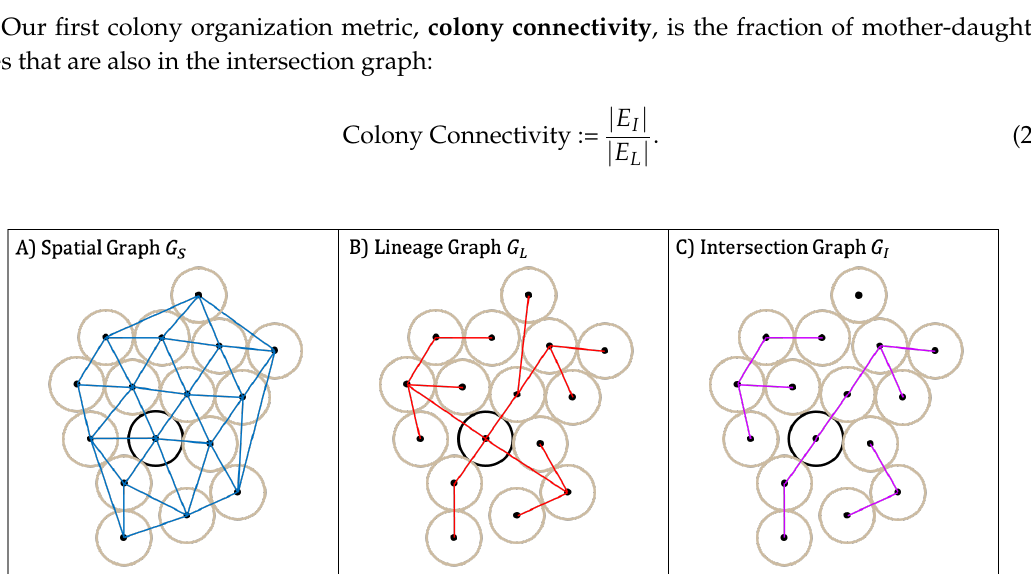
Figure 16. Colony Spatial Graphs. The vertex set for all three colony graphs is the same (all cell centers). The founder cell is designated in black. The edge set differs depending on the relationships between cells; ( A ): The edge set for the spatial graph G S (blue edges) are those induced by the the Delaunay triangulation applied to the cell centers (Equation (17)); ( B ): The edges for the lineage graph G L (red edges) correspond to mother-daughter pairs (Equation (18)); ( C ): The edge set for the intersection graph G I (purple edges) include those edges that belong to the two previous edge sets (Equation